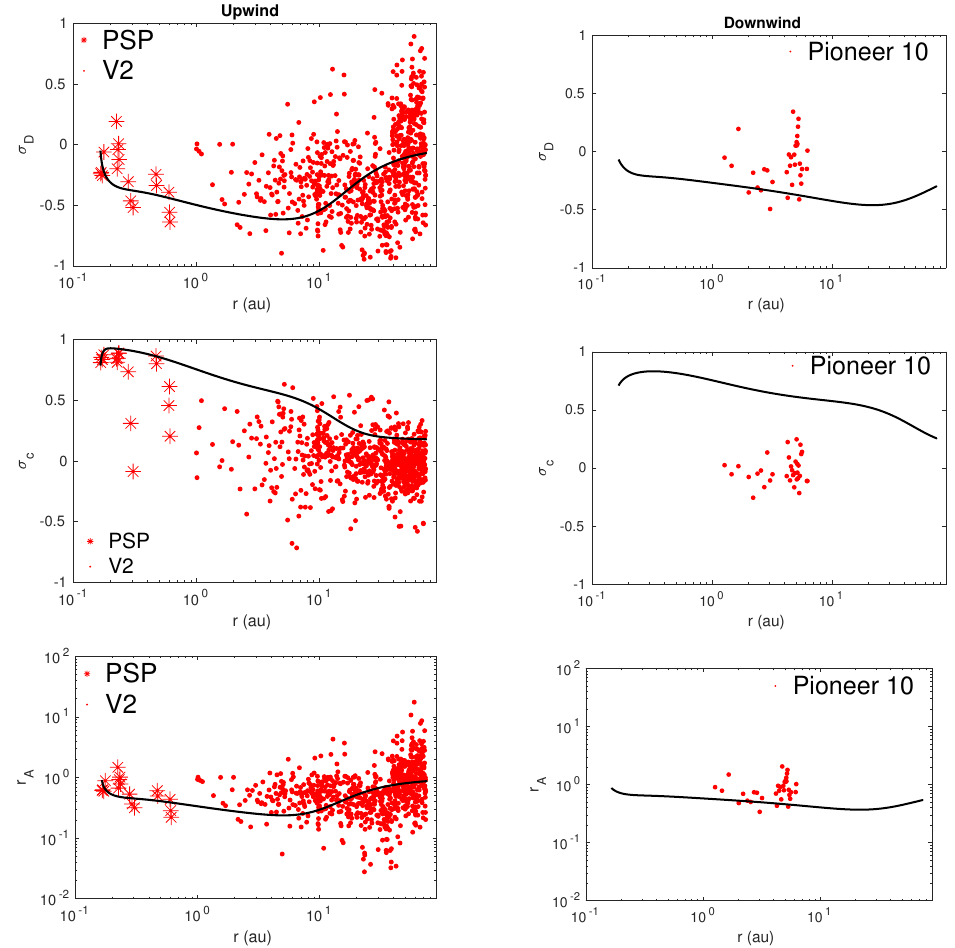
Figure 3. From top to bottom in the upwind direction ( left column) and the downwind direc- tion ( right column), the theoretical and observed normalized residual energy, normalized cross- helicity, and Alfvén ratio are compared as a function of heliocentric distance. The solid curves denote the theoretical results. The red “*” and “.” symbols represent the PSP and Voyager 2 measurements,